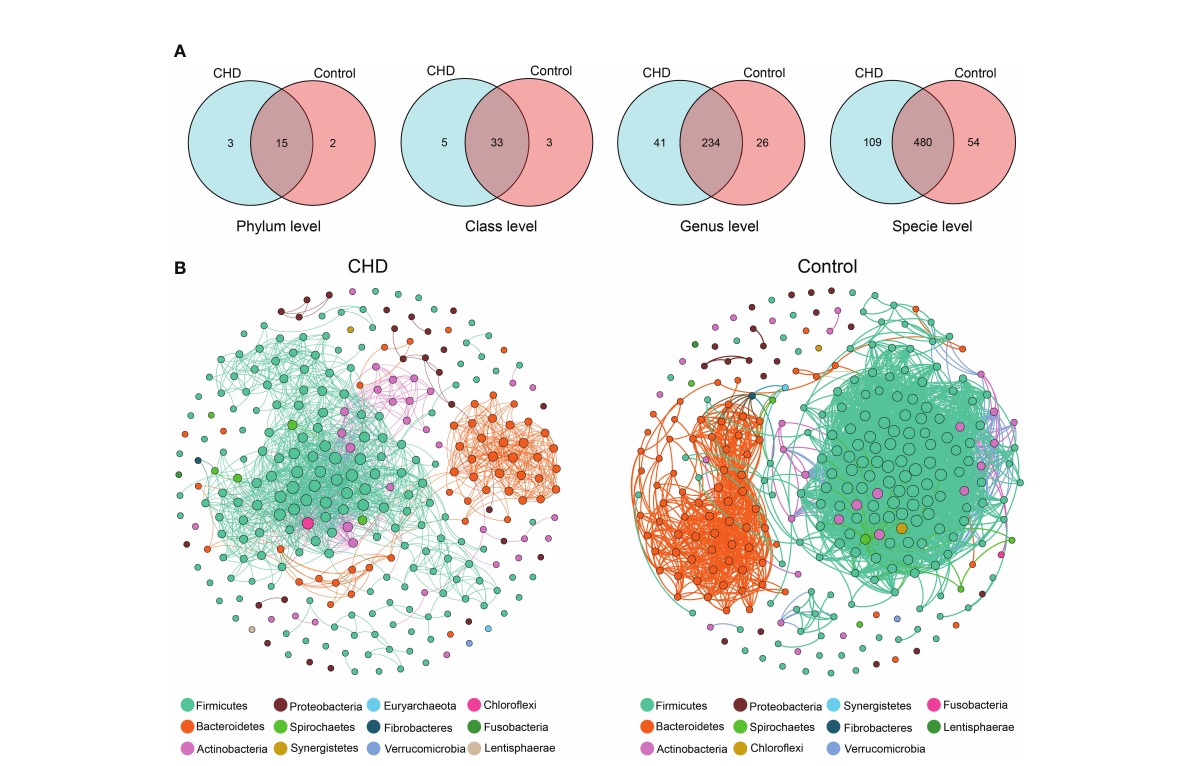
FIGURE 3 Species variations and co-occurrence networks between CHD and control groups. (A) Venn diagrams of species variations at phylum, class, genus, and species level. (B) Co-occurrent networks in CHD and control groups. Links denote signi fi cant ( ‘ holm ’ adjust p-value < 0.001 and Spearman ’ s absolute r > 0.8) correlations with ‘ holm ’ adjust and weight by each correlation. The nodes in network are colored according to phylum and weight by the node degree of each